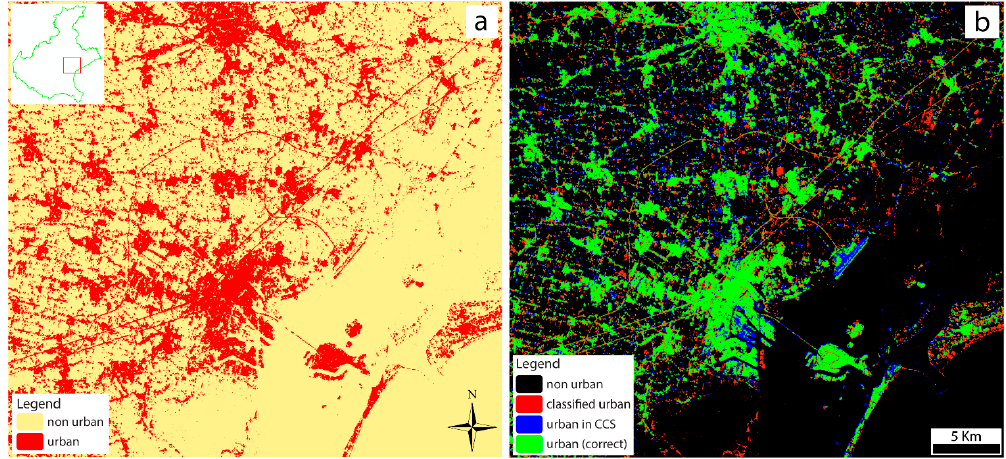
Figure 8. ( a ) Supervised classification (using random forest (RF) classifier) run over a stack of interferometric coherence images produced processing a time series of Sentinel-1A images acquired from April 2019 to July 2018. ( b ) Accuracy assessments using CCS as a reference map (see Figure 7 for details). Table 4. Error matrix related to RF classification performed on the multitemporal coherence image in the Venice study area.